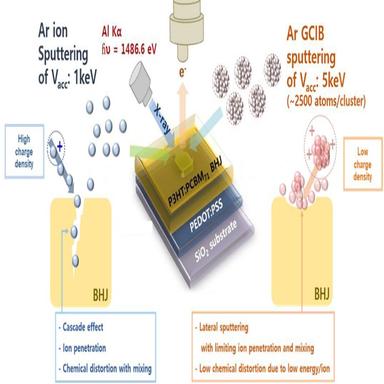
(a) C 1s and (b) S 2p XPS core level spectra and (c) atomic concentration depth profiles of pure poly(3-hexylthiophene) film obtained using continual Ar ion and Ar gas cluster ion beam sputtering.